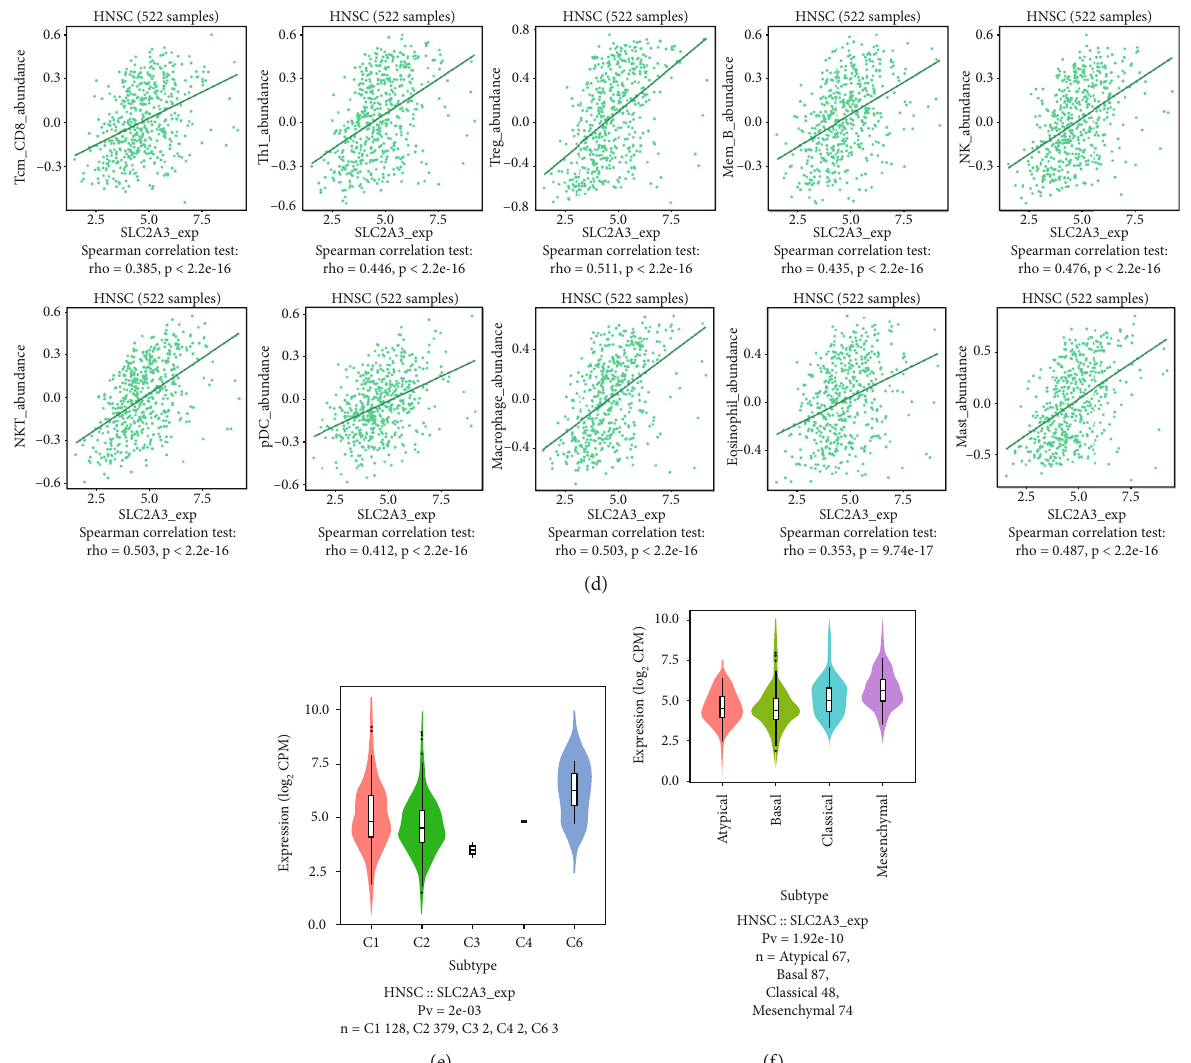
Figure 7: Correlation between SLC2A3 expression and immune cell in fi ltration. SLC2A3 expression was signi fi cantly related to the abundances of B cells, CD8 + T cells, CD4 + T cells, macrophages, neutrophils, and dendritic cells (a). Cumulative survival was poor signi fi cantly associated with the abundance of B cells (b). Correlations between expression of SLC2A3 and 28 TIL types across human cancers, investigated using the TISIDB database (c). SLC2A3 was signi fi cantly correlated with abundances of Tcm CD8 cells, Th1 cells, Treg cells, Mem B cells, NK cells, NKT cells, pDCs, macrophages, eosinophils, and mast cells (d). Relationship between SLC2A3 expression and immune subtypes (e). Relationship between SLC2A3 expression and molecular subtypes